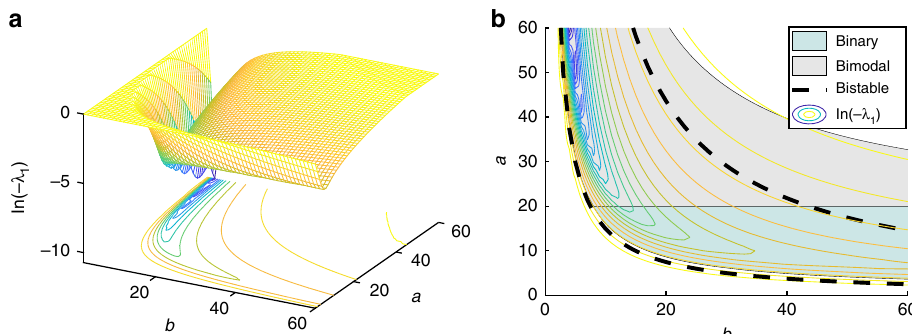
Fig. 3 Evolution of the eigenvalue and bimodality and bistability regions in the parameter space. a Eigenvalue λ 1 in the parameter space computed from in the parameter space. Regions of bimodality and bistability are computed by the algorithm in Pájaro et al. 20 matrix M (logarithmic scale). b Contour of λ 1 (logarithmic scale). The fi gure shows how the eigenvalue evolves with parameters a ;